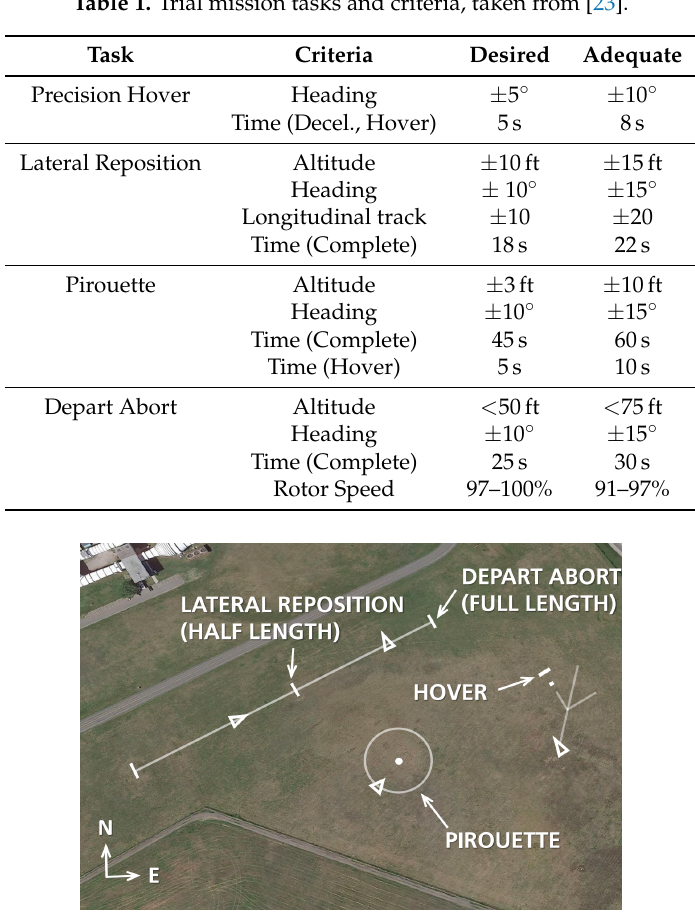
Figure 5. ADS-33 test course located at National Research Council (NRC),